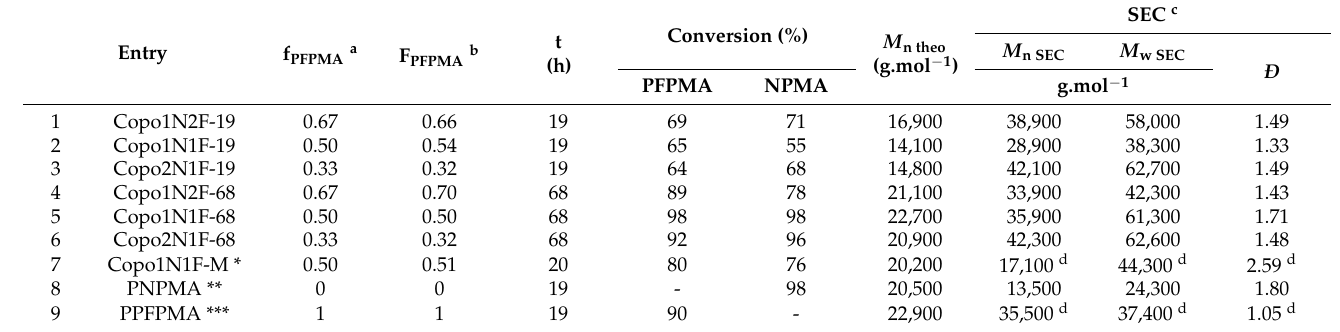
Table 1. Summary of results for Cu(0)-mediated RDRP of NPMA and PFPMA at different